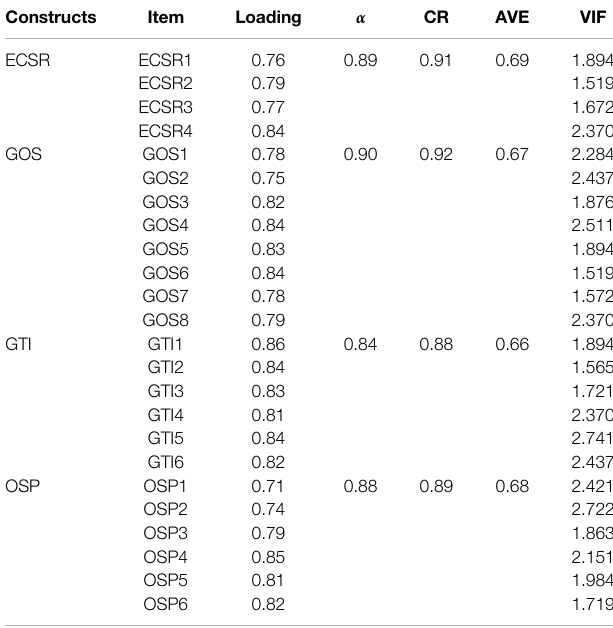
TABLE 4 | Reliability and validity.